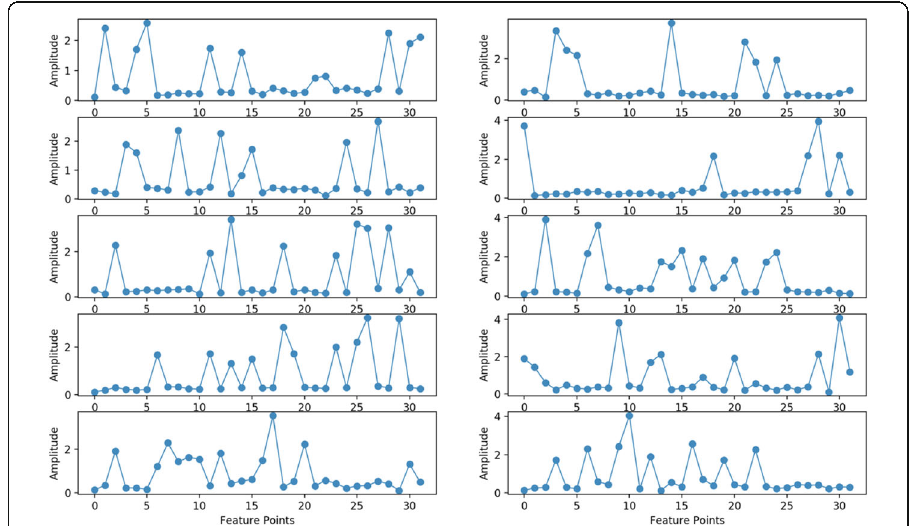
Fig. 15 batch chip feature map of